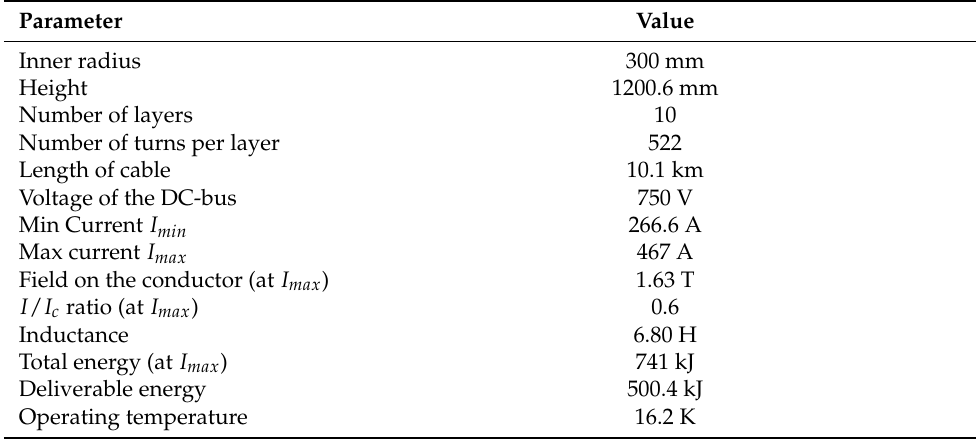
Table 2. Main characteristics of the MgB 2